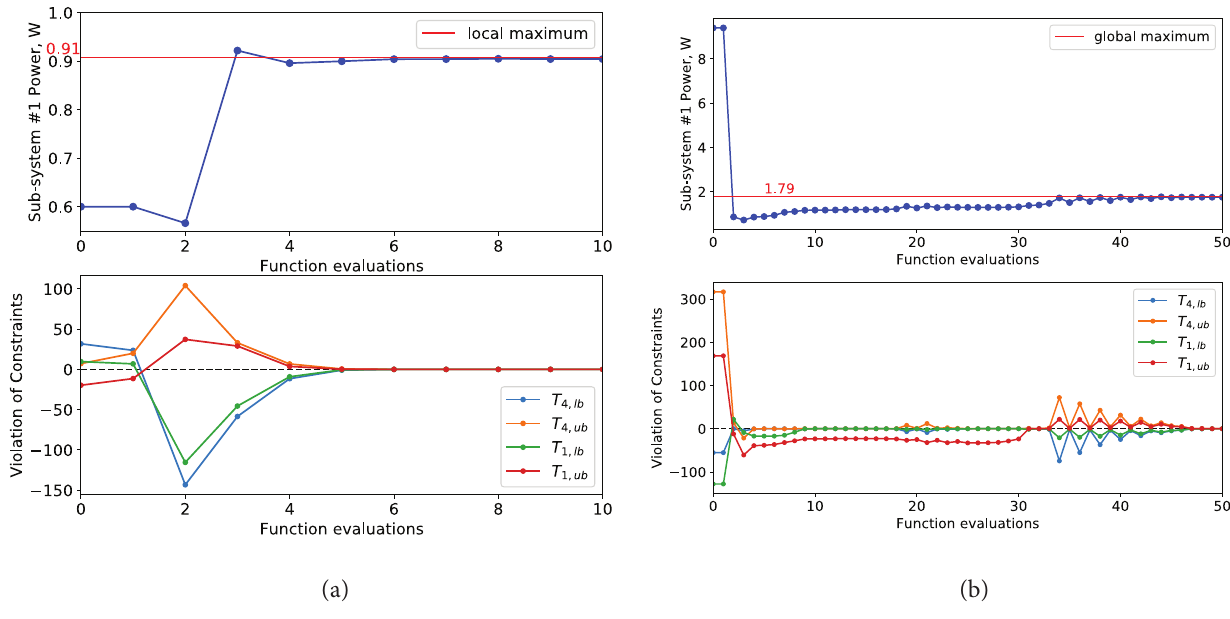
Figure 10. Optimization progress of objective function and temperature constraint (in Kelvin scale) violations for (a) the initial optimizer run and (b) the best solution optimizer